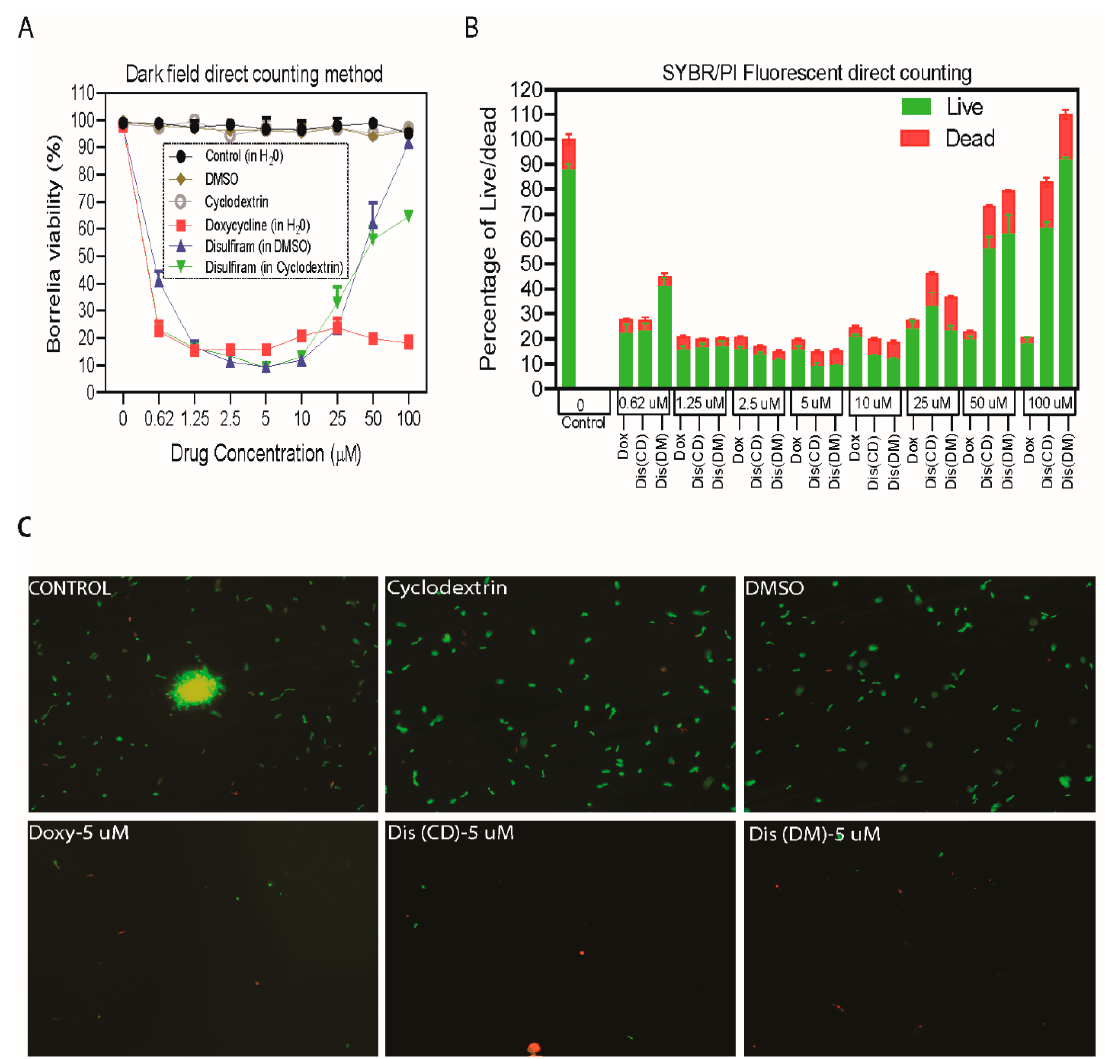
Figure 2. Evaluation of the activity of disulfiram (in DMSO and cyclodextrin) with doxycycline as control. An eight-day-old, B. burgdorferi stationary phase culture of B. burgdorferi was incubated for four days with disulfiram (Dis-DM) disulfiram, (Dis-CD) and doxycycline (Doxy) at the same drug concentrations of 100 µM to 0.625 µM respectively. After a five-day incubation, bacteria cell viability was assessed by ( A ), by direct counting using dark field microscopy and ( B ), by SYBR Green-I/PI assay using fluorescent microscopy. ( C ), Representative images were taken using SYBR green-fluorescent stain (live organisms) and propidium iodide red-fluorescent stain (dead organisms) at 200 × magnification. All these experiments were repeated at least three times ( n = 6). Error bars represent standard errors.